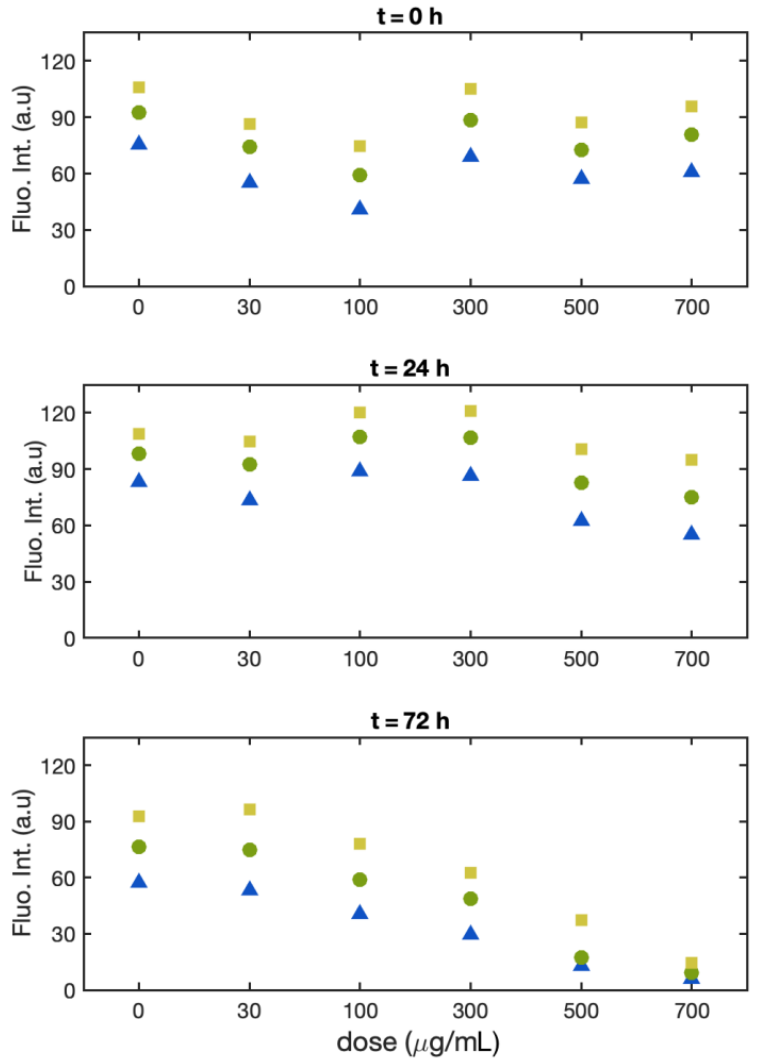
Figure 5. Batch 3: Normalized fluorescence intensity of the single alga cells at the 25th percentile (black square), median (red dot), and 75th percentile (blue triangle) as a function of Cu(II) concentration at t = 0 (upper panel), t = 24 h (middle panel), and t = 72 h (lower panel).